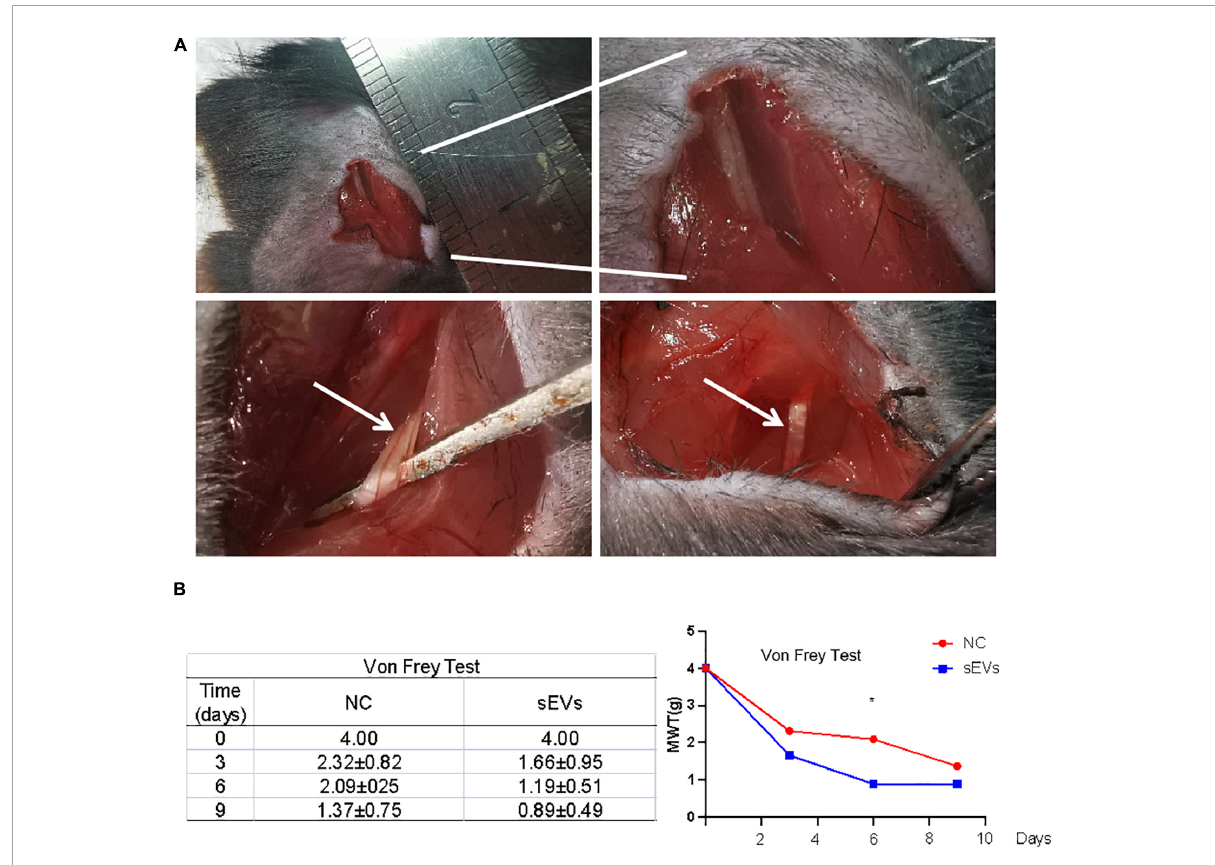
FIGURE4 Monitoring of functional repair after sciatic nerve injury in mice. (A) A murine SNI model was established via open-field isolation of the mouse sciatic nerve and pressure-damaged sciatic nerve filaments. (B) Von Frey experiment: Paw withdrawal threshold was monitored to observe changes in pain threshold in control and sEV-treated mice. Statistical significance, p < 0.05. ∗ Significant